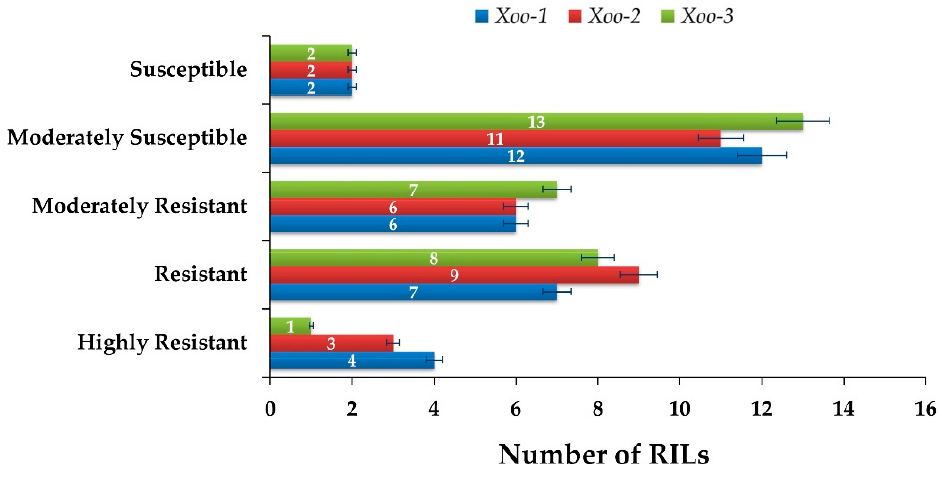
Plants 2023 , 12 , x FOR PEER REVIEW Figure 6. Response of RILs plants to BB isolates. Figure 6. Response of RILs plants to BB isolates. Table 2. Lesion percentage and responses of selected RILs of rice.